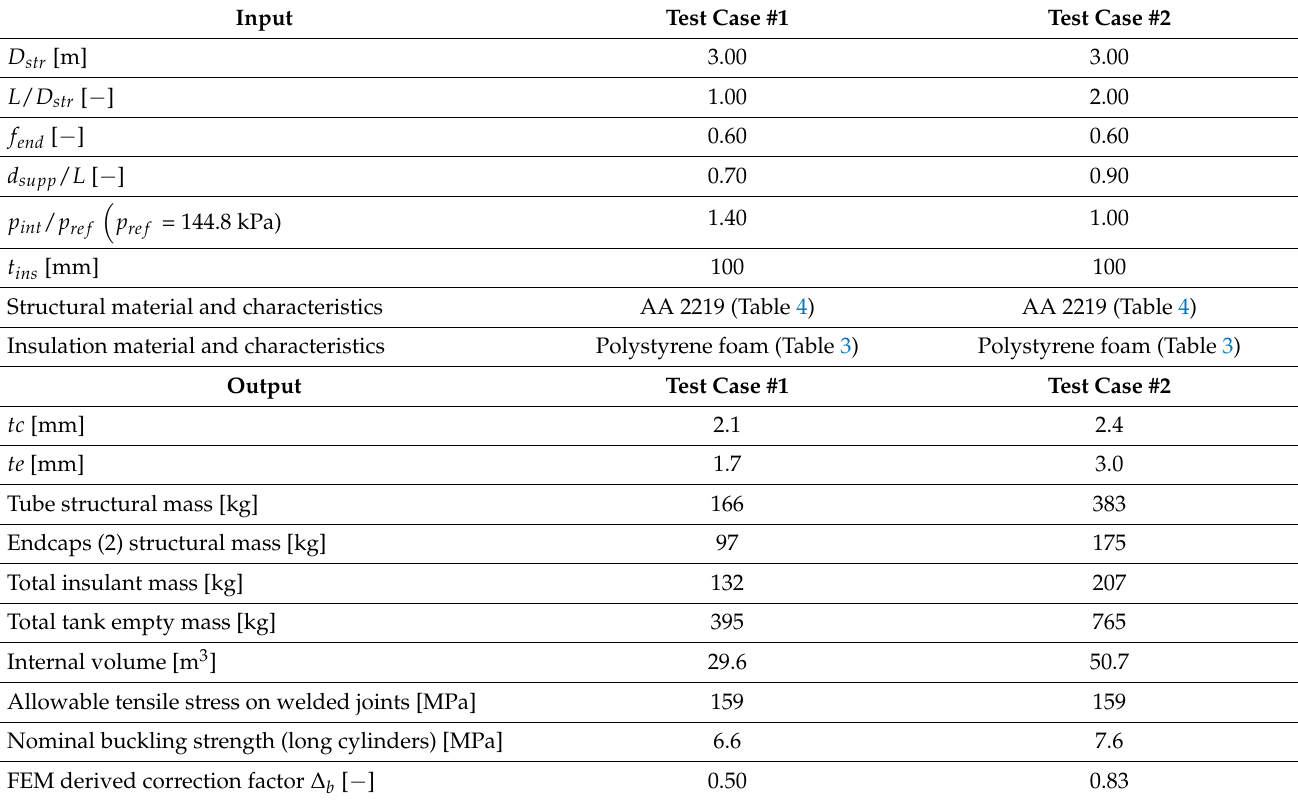
Table 5. Input and output of the analytical model for two test